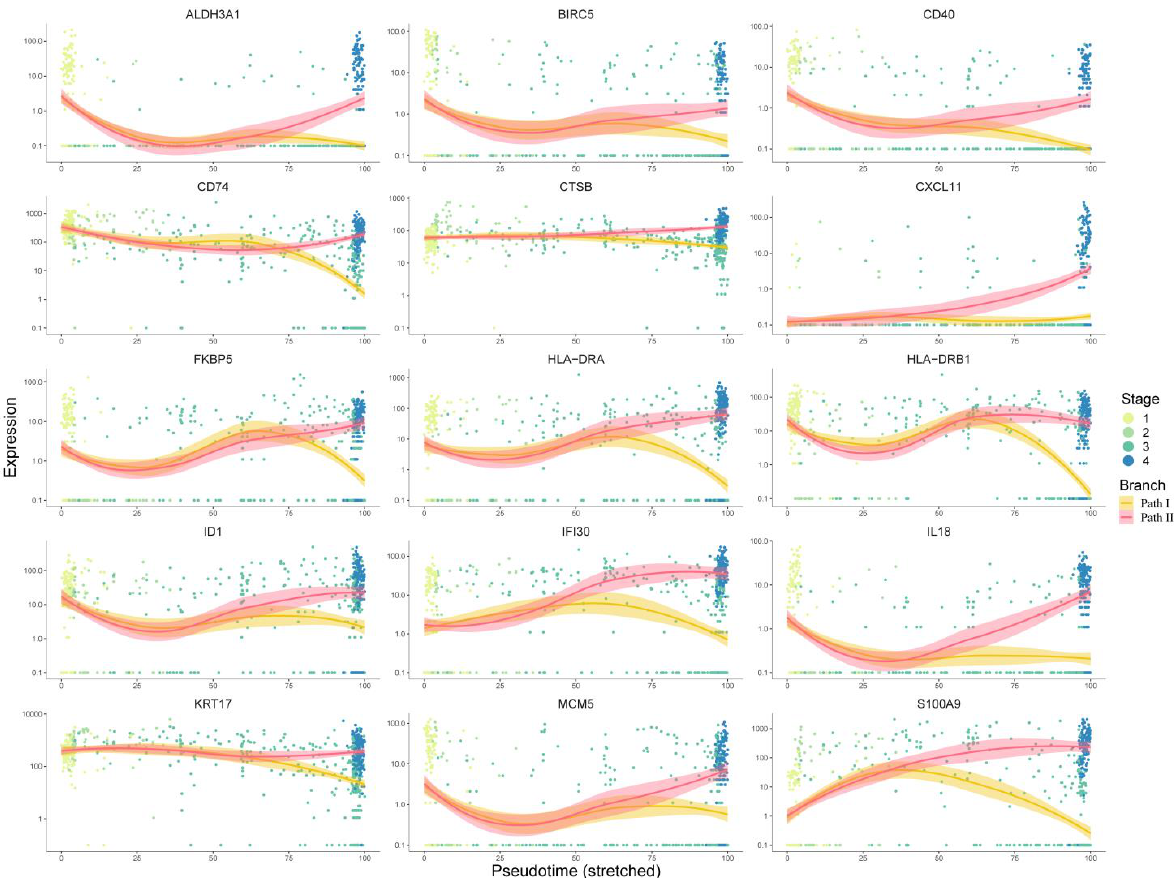
Figure 6. Analysis of 15 target genes’ expression trends: This figure shows the expression trends of genes progressing with pseudo-time. The x -axis represents pseudo-time, while the y -axis represents the gene expression level. Dots represent cells, which are colored according to clinical stages. The curves were fitted by gene expression level, and the colors represent two different development paths in the cell trajectory.